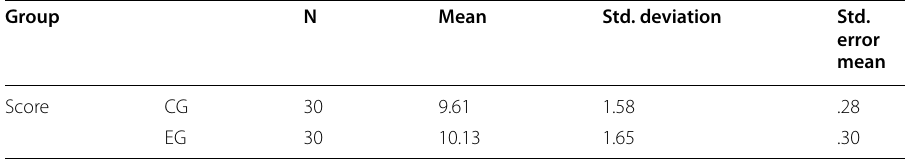
Table 11 Complexity pretest descriptive statistics Group N Mean Std. deviation